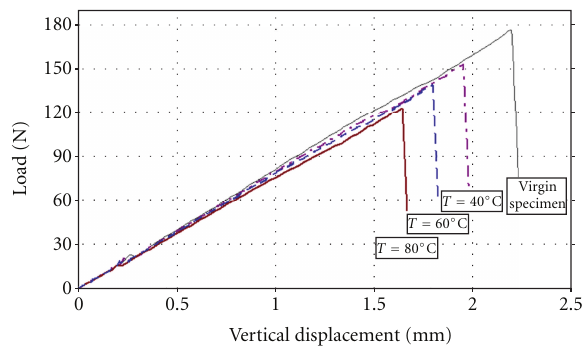
Figure 7: Variation of the flexural sti ff ness as a function of di ff usion coe ffi cient and aging temperatures for specimens aged at various temperatures in 60%